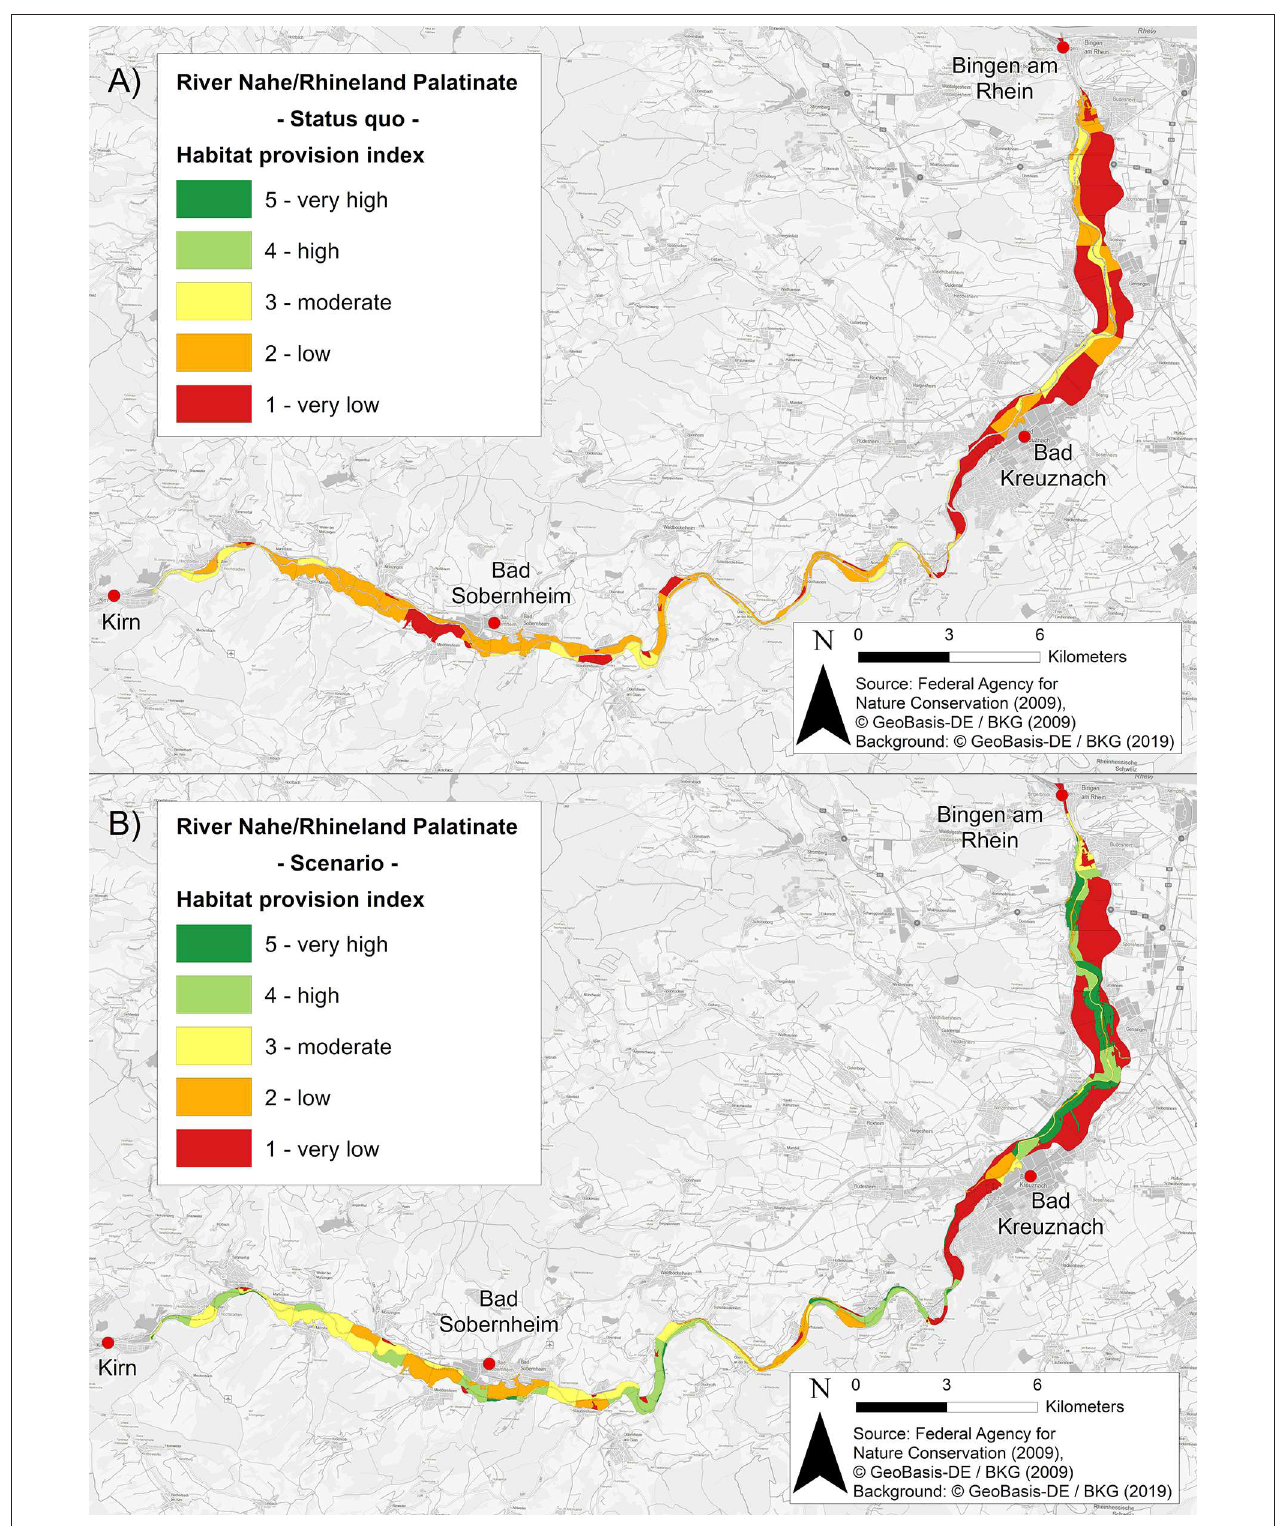
FIGURE 3 | Assessment of the ecosystem service habitat provision according to the developed index showing (A) the status quo and (B) restoration scenario of the River Nahe separated into active and former floodplain compartments (see Figure 1B ). Habitat provision index classes: 1, very low; 2, low; 3, medium; 4, high; 5, very